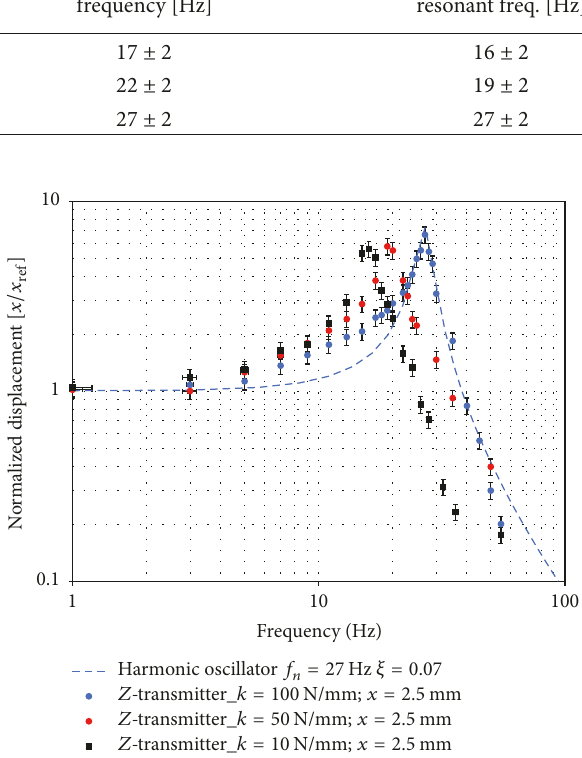
Figure 19: Normalized displacement versus frequency for three different motion